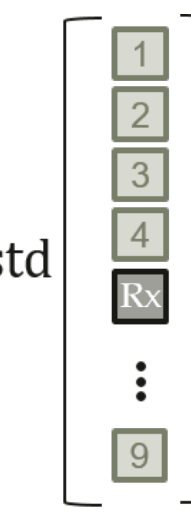
Figure 7. Conceptual drawing showing how the uncertainty related to the DEM measurement is evaluated based on the rover’s horizontal